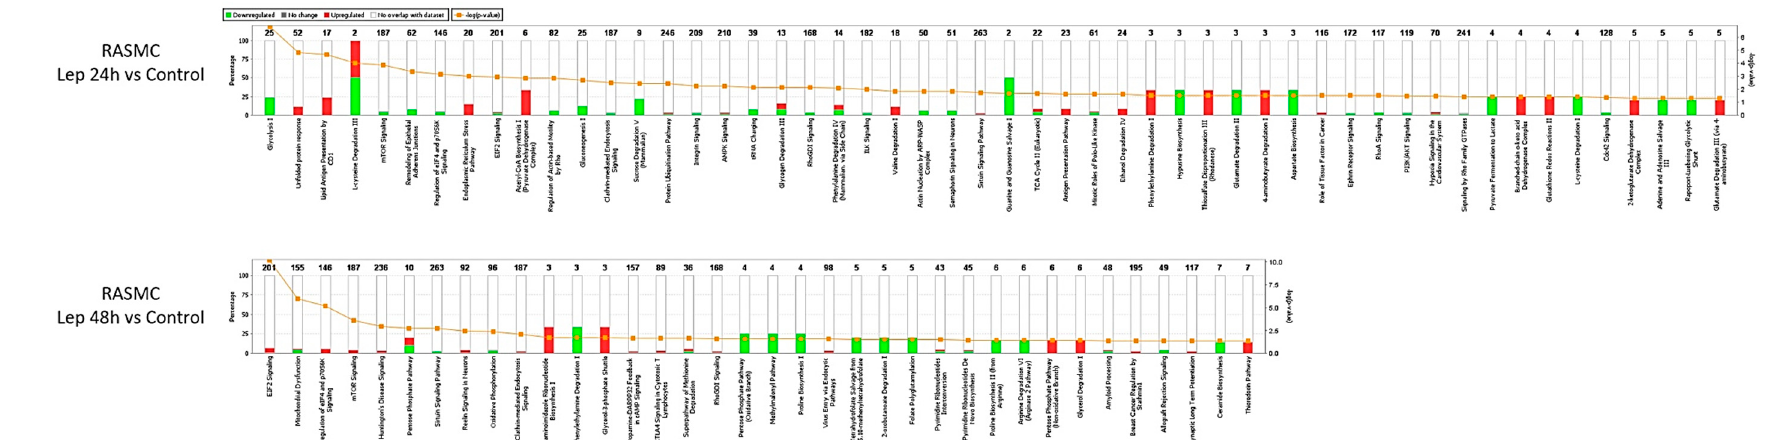
Figure 6. The regulated canonical pathways in response to leptin stimulation in RASMC samples. Altered canonical pathways in response to the protein profile in the leptin 24 h and 48 h stimulated vs. control samples. Each altered canonical pathway is represented in a bar graph. The downregulated proteins are represented by green on the graph, whereas the upregulated proteins are represented by red on the graph.